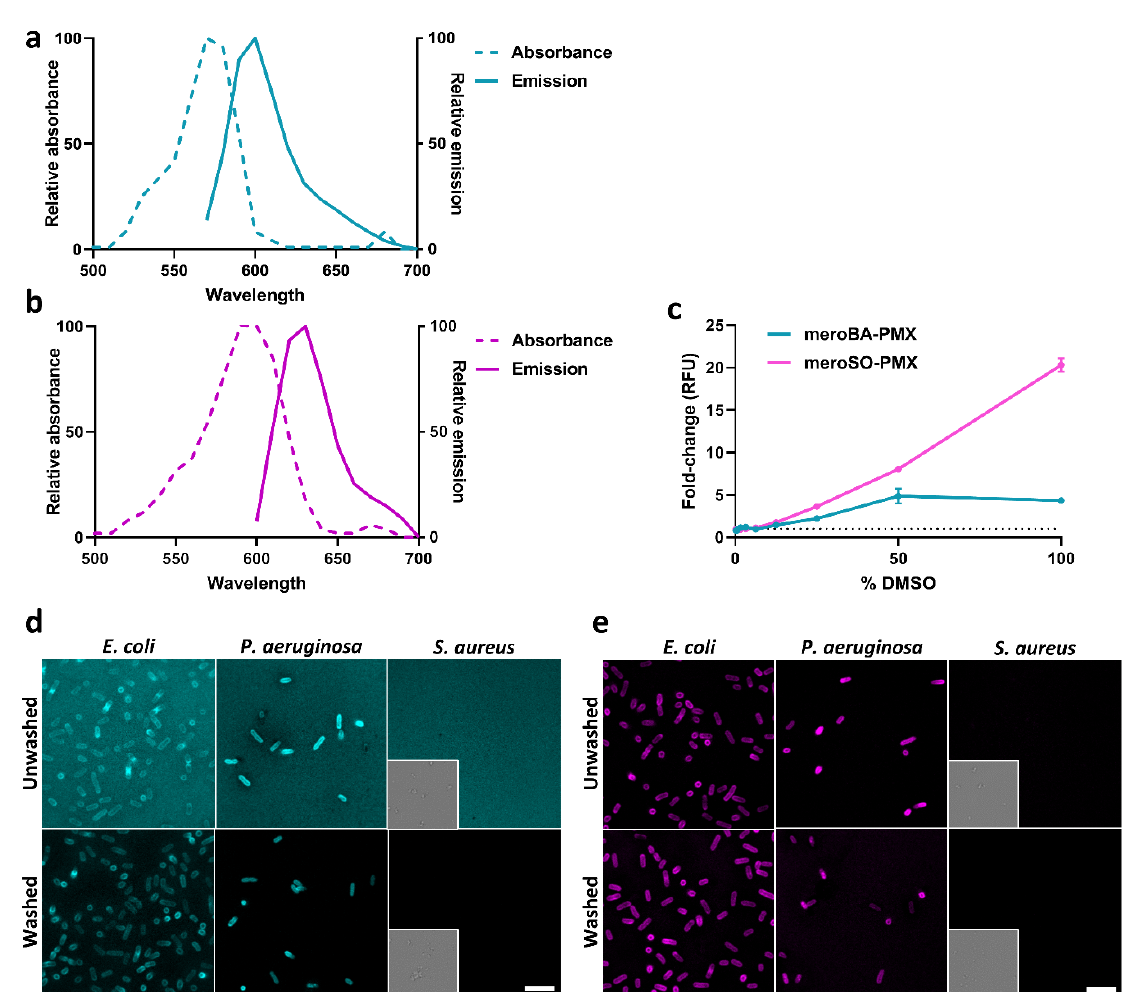
Figure 6. Characterization of the merocyanine-PMX bacterial imaging agents. ( a ) The normalized excitation and emission spectra of meroBA-PMX 12. ( b ) The normalized excitation and emission spectra of meroSO-PMX 13 . ( c ) The fluorescence increase attributed to the solvent for each of the imaging agents. Data shows the mean of independent repeats, error bars show s.e.m. n = 3 (where the point is bigger than the error bar, the error bar is not shown.) ( d ) Representative images of confocal laser scanning microscopy of meroBA-PMX ( 12 , 5 μM) and ( e ) meroSO-PMX ( 13 , 5 μM) with live bacteria showing ‘Unwashed’ and ‘Washed’ conditions. Inserts for S. aureus shows brightfield images. Scale bar shows 5 μm. n = 3.